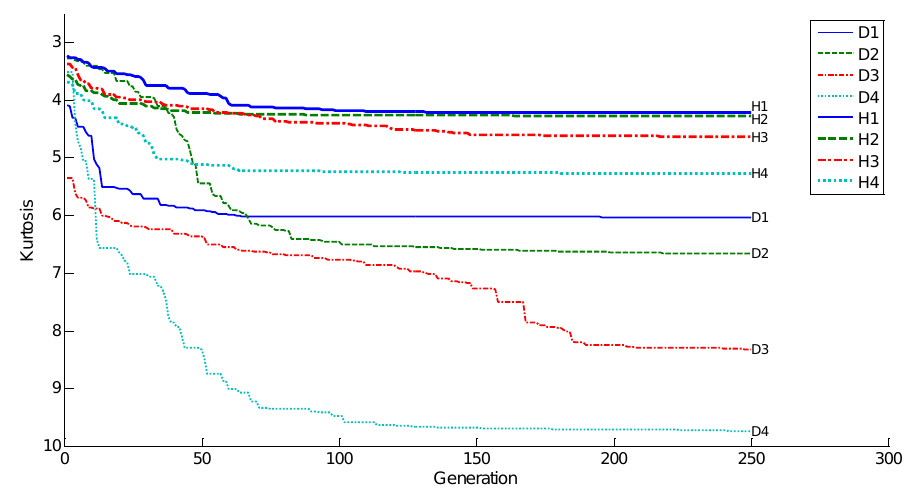
Figure 13. Comparison of the convergence rates of EMD-GA on a single healthy (H1–H4), and four damaged bearing cases (D1–D4).